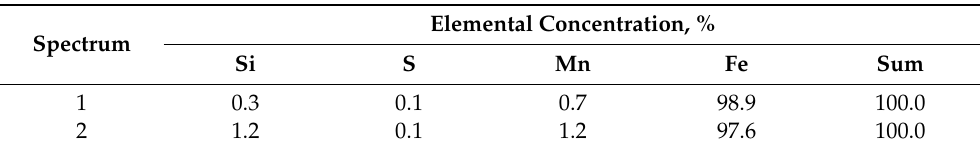
Table 2. Analysis of the composition of the initial steel 3 and channel element section in steel 3 after dynamic alloying in the SDP